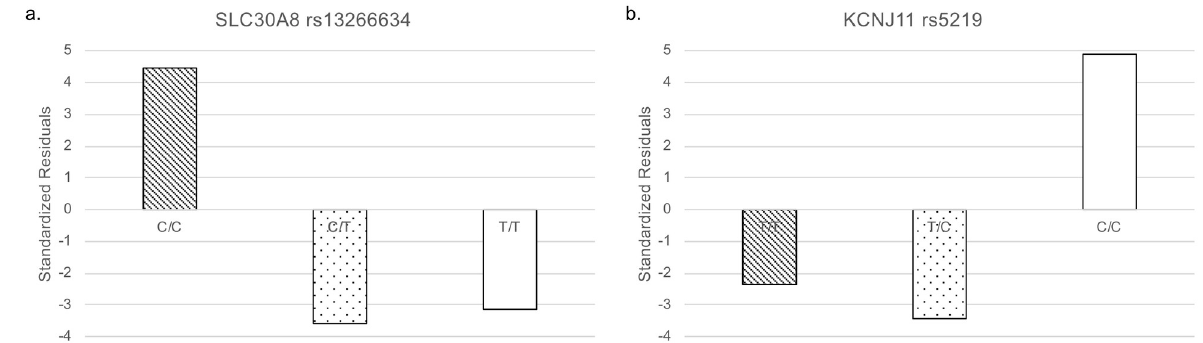
Fig 3. Standardized residuals of genotypes. White: homozygote non-risk alleles, dotted: heterozygote, and diagonal stripes: homozygote of risk alleles. (a) SLC30A8 rs13266634. (b) KCNJ11 rs5219.